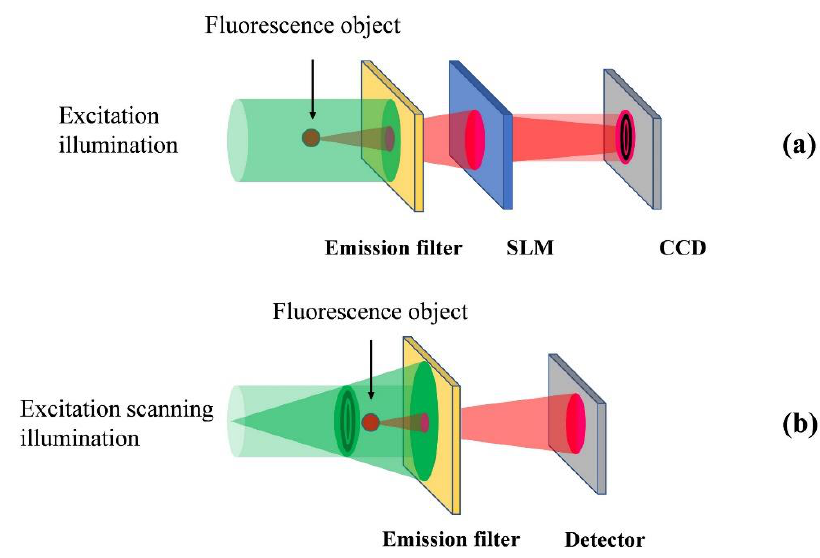
Figure 5. Setups of fluorescence holography: ( a ) Fresnel incoherent correlation holography (FINCH), and ( b ) optical scanning holography (OSH).